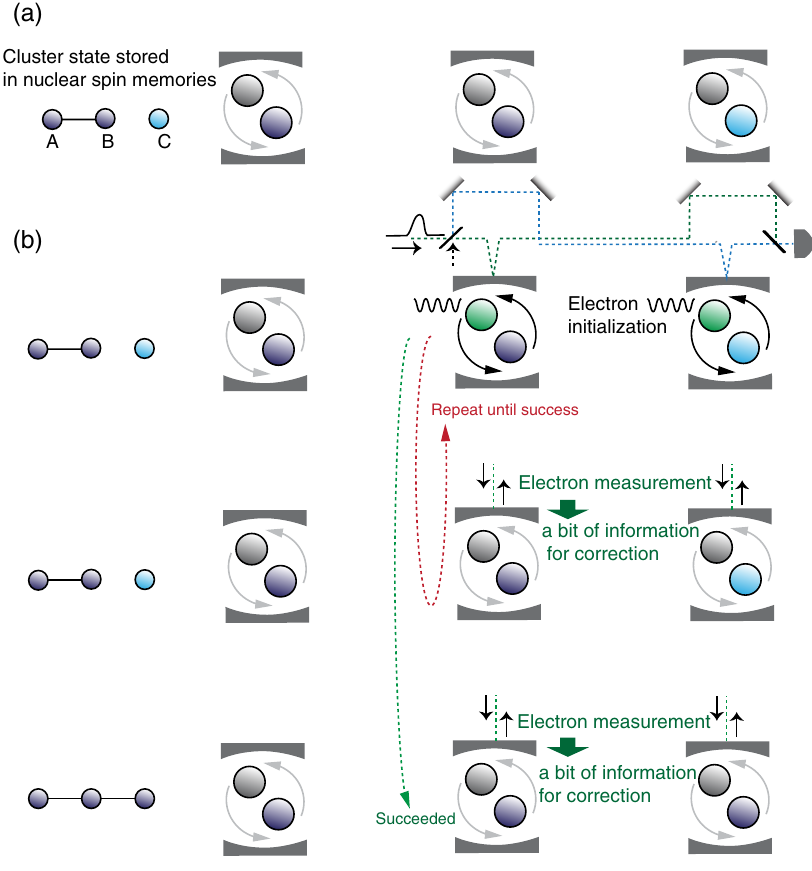
FIG. 3. The repeat-until-success protocol is accurately time sequenced. This is required by the nature of the coupling, as entanglement between the electron spin and nuclear spin oscillates. Upon failure, we wait until the 2 π point in the entangling cycle, where the nucleus and electron are decoupled. The nuclear spin is consequently protected from feedback errors through the hyperfine coupling by accurately timing the reinitialization of the electron spins. When the distribution of entanglement between two electrons succeeds, the entanglement bond will be transferred to the nuclear spins by waiting until a π point where the electron and nuclear spins are maximally